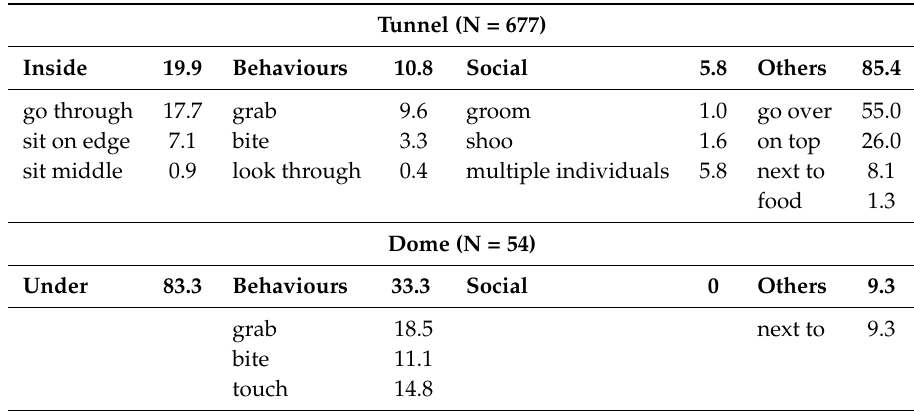
Table 2. Codes describing interactions with the prototype and percentage of each instance over all interaction events. Codes are split by animal placement for the interaction, behaviour, social usage and other codes. Codes are shown in %.